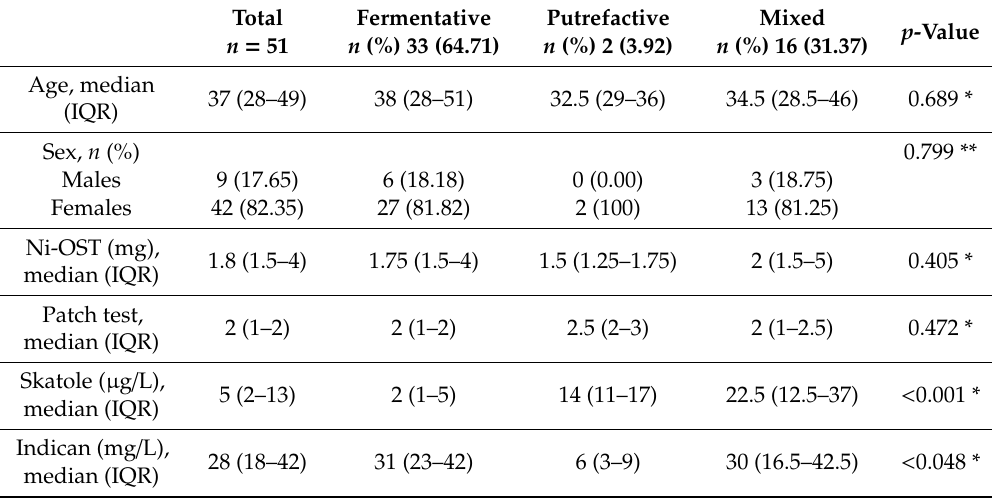
Table 2. Characteristics of the patient samples stratified by dysbiosis type.